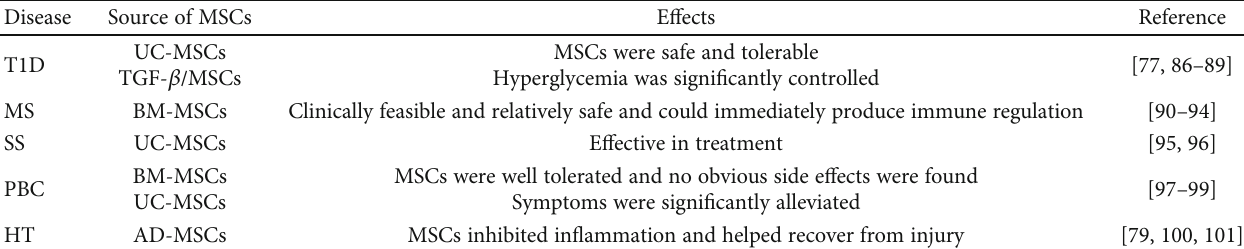
Table 2: The application of MSCs in other autoimmune diseases.